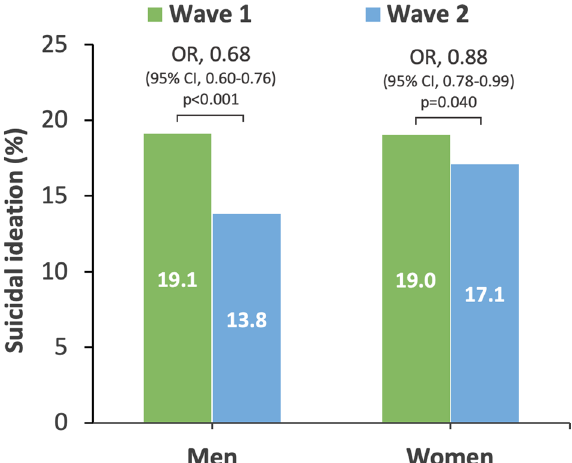
Figure 3. Suicidal ideation by gender in wave 1–2. CI confidence interval, OR odds